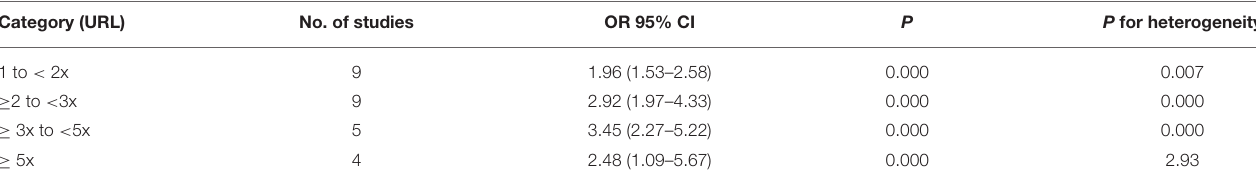
TABLE 2 | Risk of short-term mortality by categories of cardiac troponin I in patients with COVID-19. Category